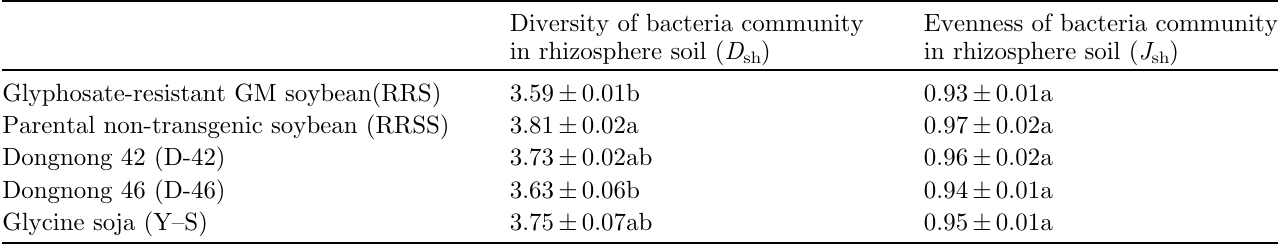
Table 2. The situation of soil with GM corps and Non-GM corps with GM soybeans and fed with non-GM soybeans.